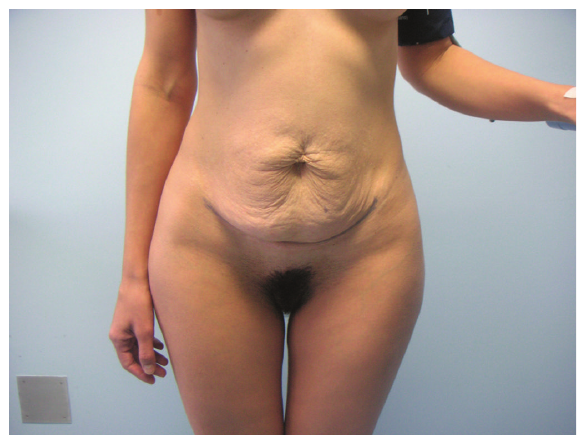
Figure 1: Anteroposterior view of a 30-year-old female patient with Cutis laxa before abdominoplasty.